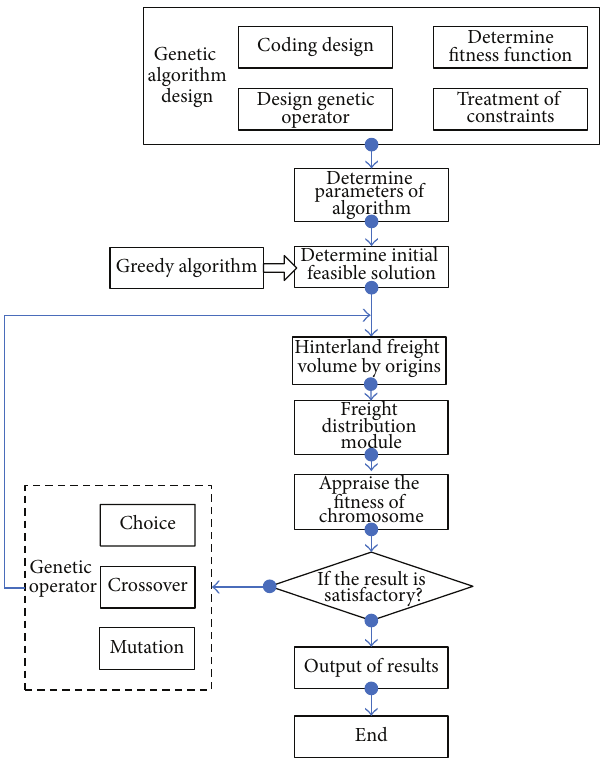
Figure 2: Process of the genetic